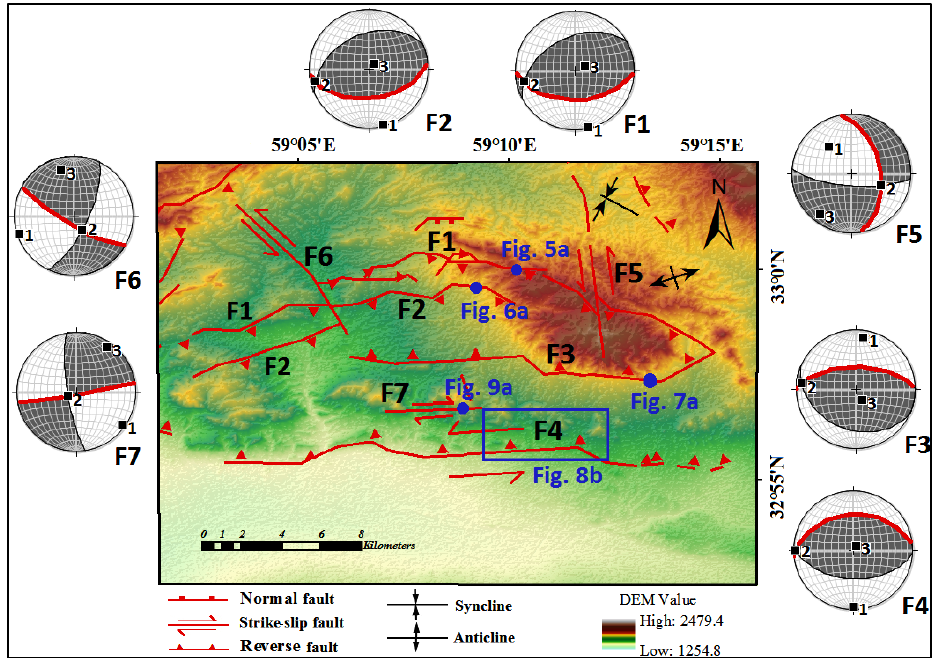
Figure 3. Digital elevation model structural map of the tectonic features. The orientation of the principal stress axes associated with faults is represented by stereonets.